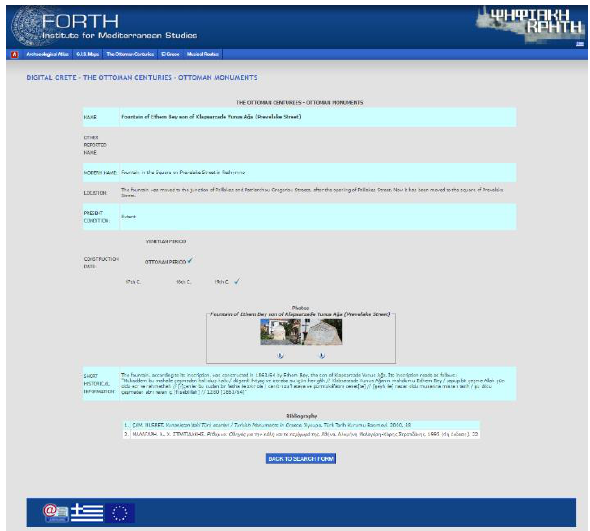
Figure 4: Example of the historical information for one specific artefact extracted (and provided as link in every point-cloud page) from the Digital Crete project